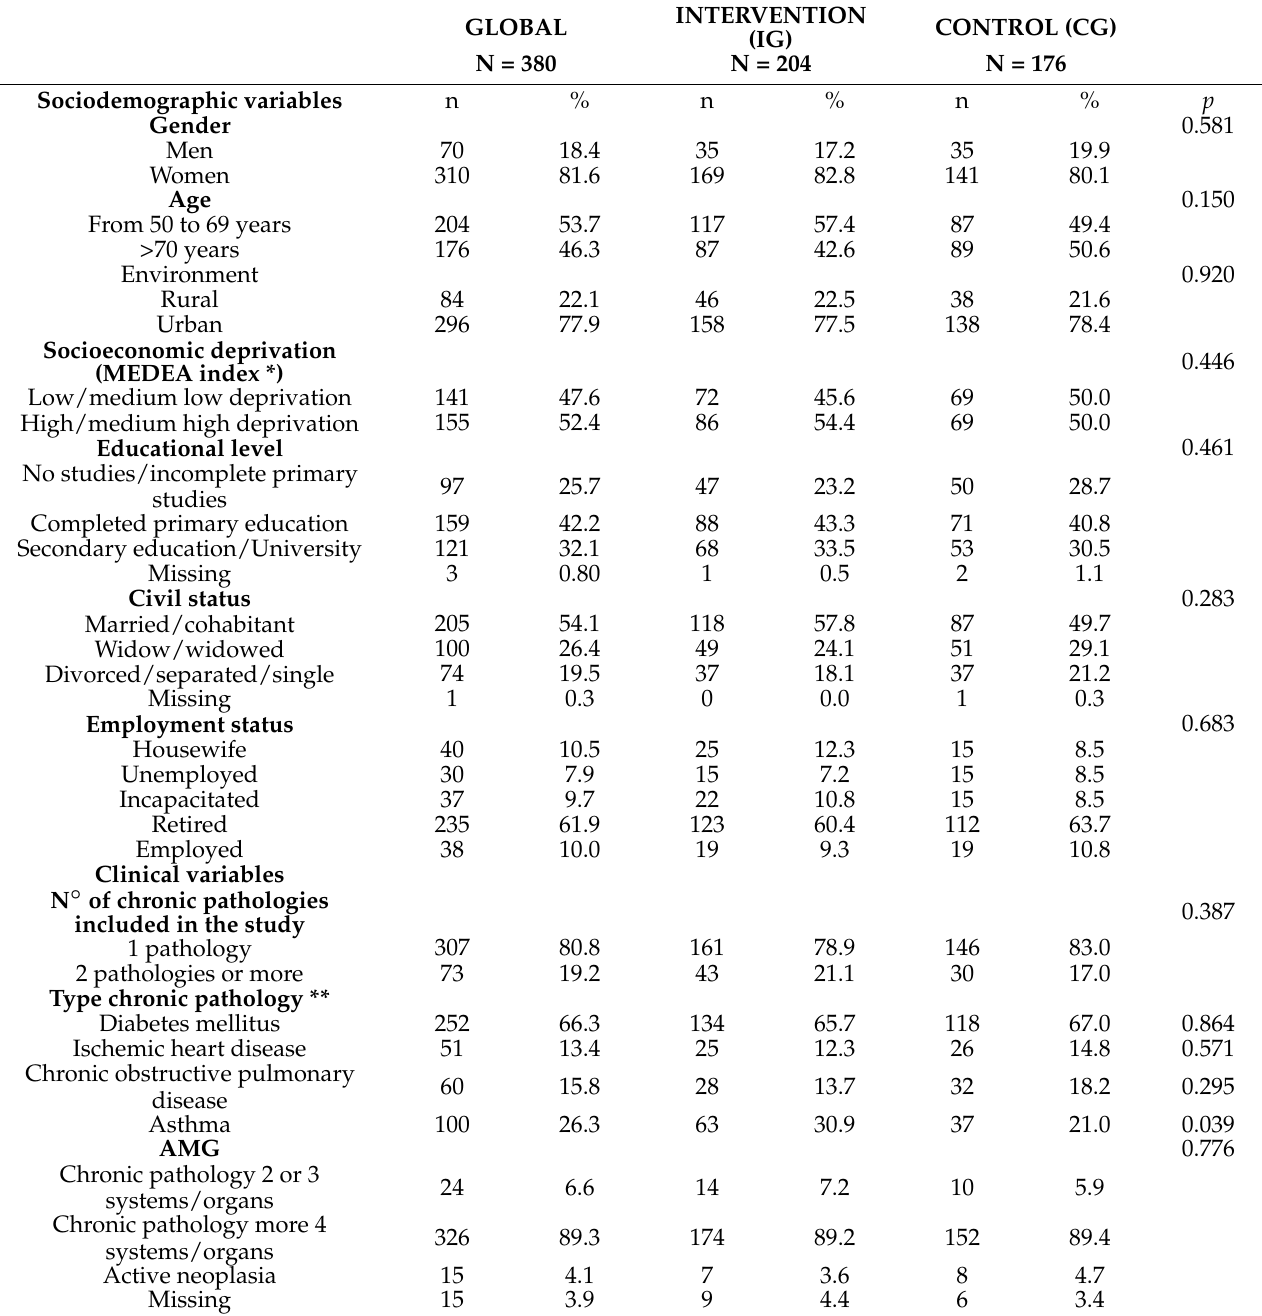
Table 1. Sociodemographic and clinical variables at